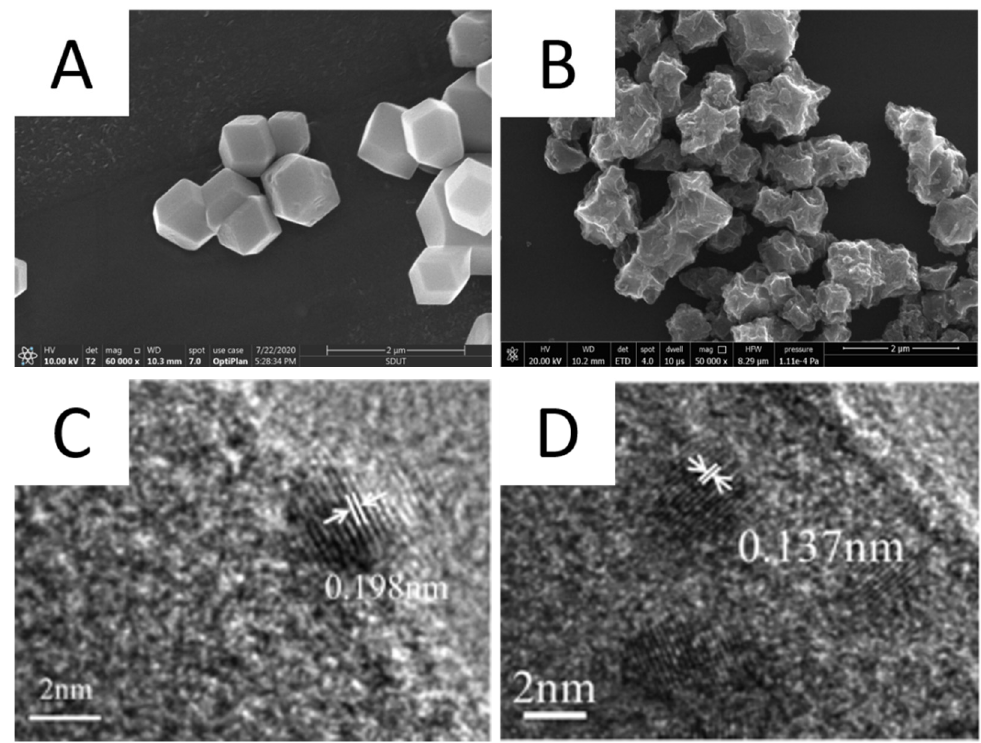
Figure 1. SEM images of Pt/Pd/ZIF-67 ( A ), and Pt/Pd/Co-N-C ( B ); HRTEM image of Pt/Pd/Co-N-C ( C , D ).